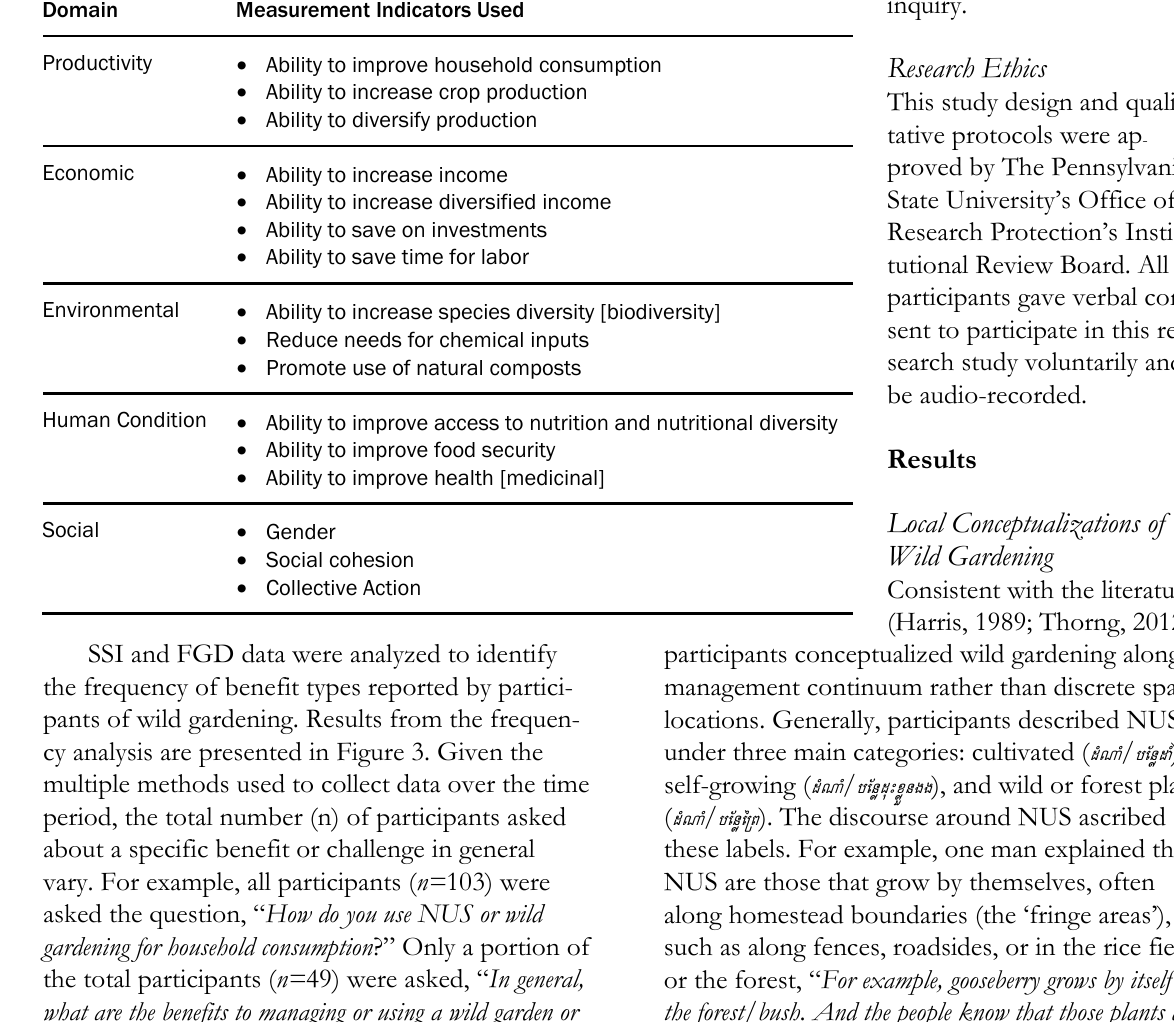
Table 2. Measurement Indicators Used to Assess SI Potential